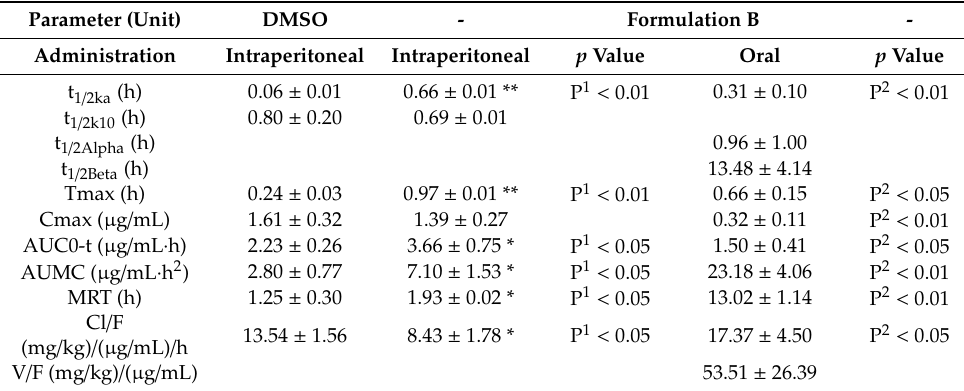
Figure 4. The mean serum concentration–time profiles of magnolol ( A ) in dimethyl sulfoxide (DMSO) and ( B ) in a microemulsion after 30 mg / kg of magnolol was administrated intraperitoneally ( C ) in a microemulsion after 30 mg / kg of magnolol was administrated orally. ( n = 3). Table 3. Estimated pharmacokinetic parameters using a one-compartment model when a dose of 30 mg / kg of magnolol in the microemulsion or in dimethyl sulfoxide (DMSO) was administrated intraperitoneally. For the oral administration study, a two-compartment model was used to estimate the pharmacokinetic parameters (Mean ± SD, n = 3).